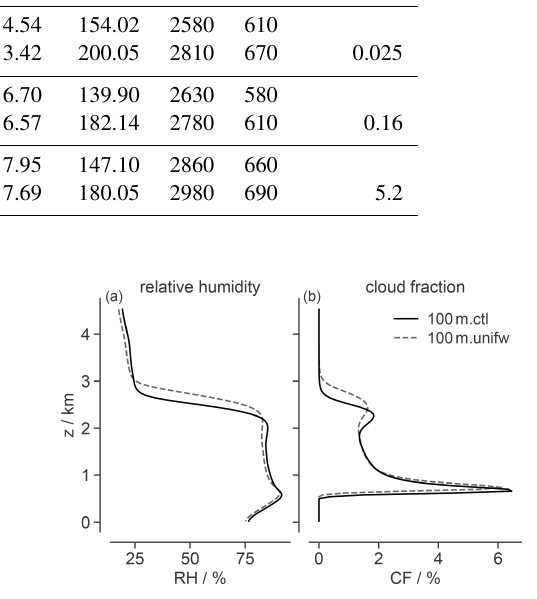
Figure 6. Profiles of second-day domain-averaged (a) RH and (b) CF for the control (solid line) and vertically uniform warmed (dashed line) simulations at 100m